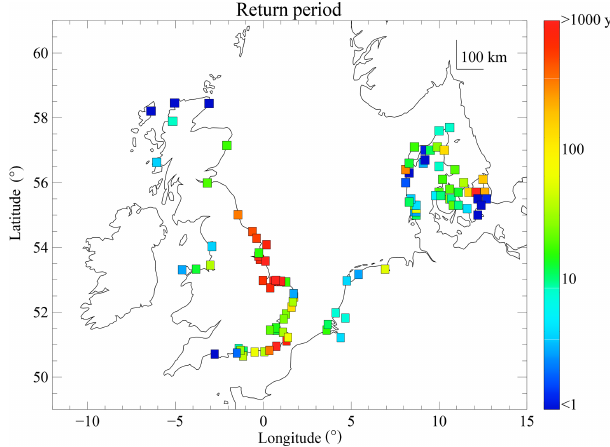
Figure 6. Map of literature reports of the return period (in years) of the maximum water level during Storm Xaver on 5–6 Decem- ber 2013. The values are based on statistical analysis of measured extreme storm surge water levels from station records that extend back to the 19th century in some cases. Table S4 presents the data used to construct this figure and a reference list of the source infor-